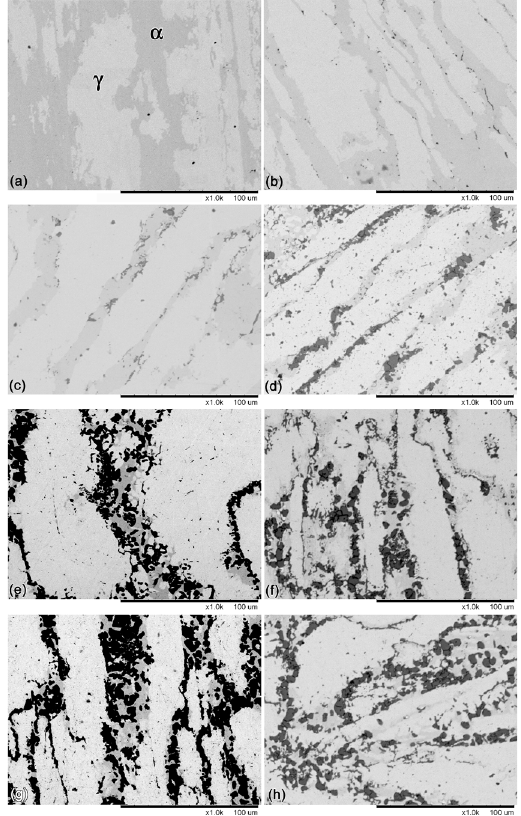
Figure 2. SEM micrographs showing the precipitation of intermetallic phases for different durations of isothermal heat treatment at 850 °C. (a) Non-aged, (b) 10 minutes, (c) 30 minutes, (d) 1 hour, (e) 2 hours, (f) 3 hours, (g) 4 hours, and (h) 5 hours.